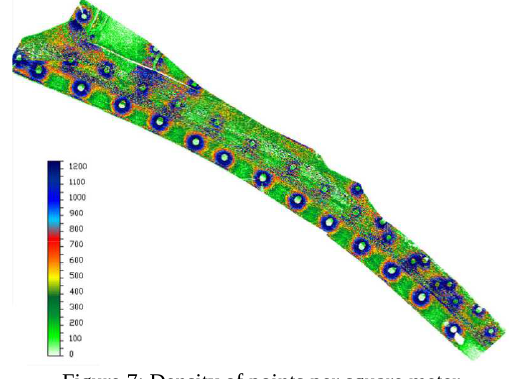
Figure 7: Density of points per square